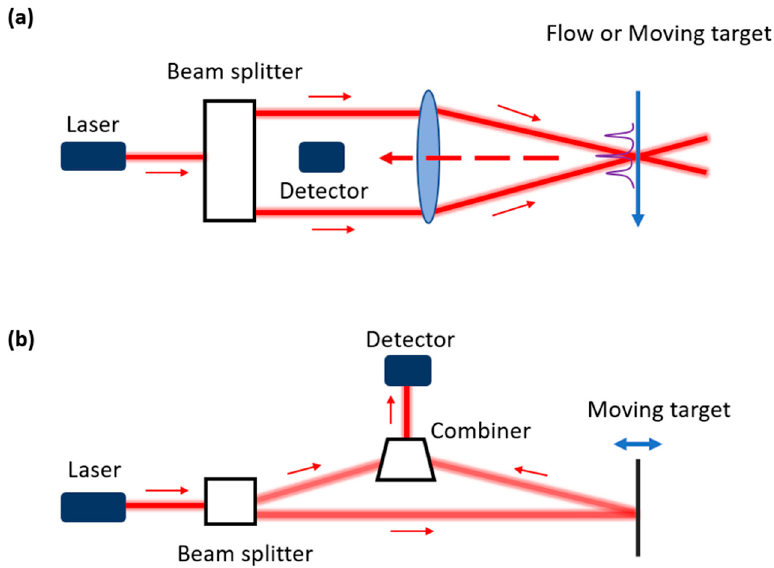
Figure 1. Schematic diagram of laser Doppler sensors using external interference ( a ) and internal interference ( b ). The external interference is usually used in laser Doppler velocimetry and the internal interference is usually used in laser Doppler vibrometry.